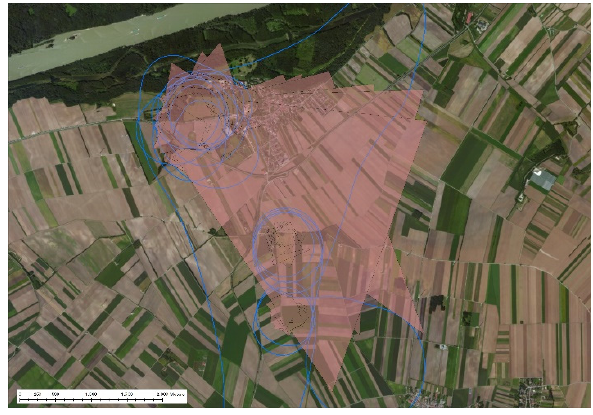
Figure 3. Fully automatized import of oblique photograph footprints based on